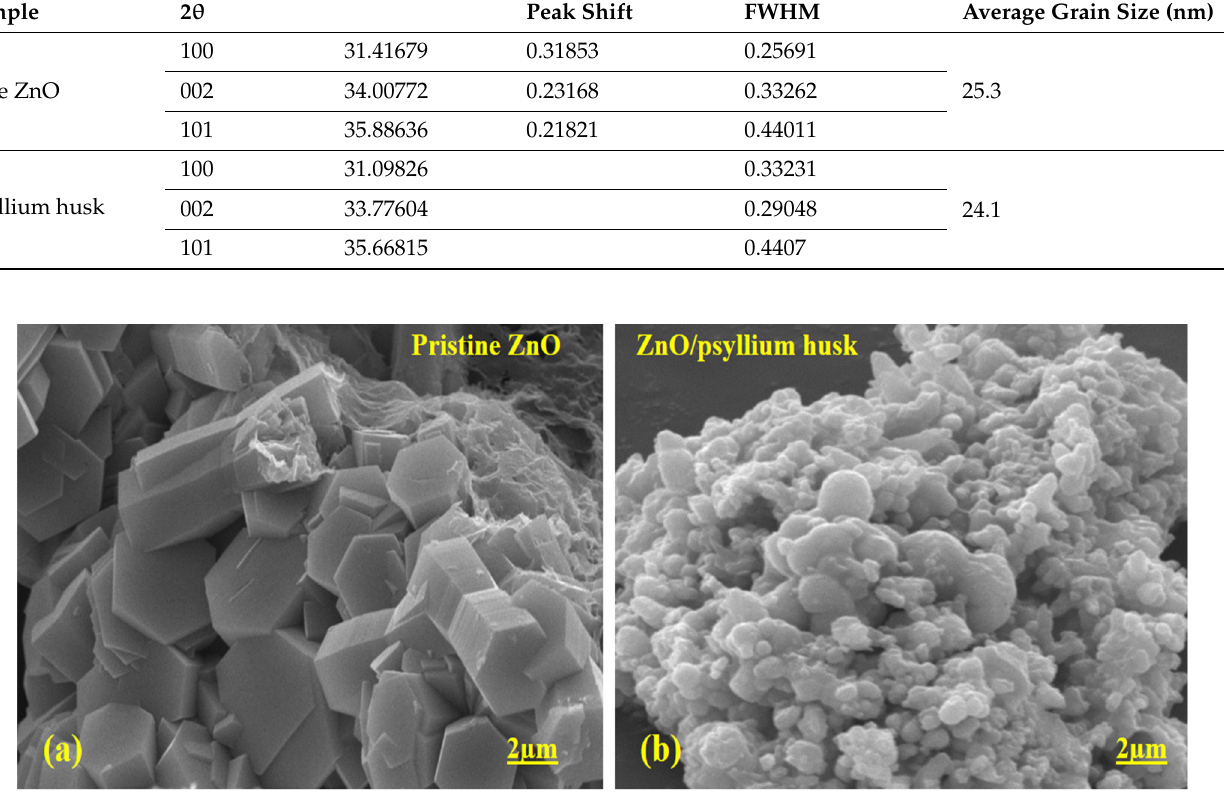
Figure 3. FTIR spectra showing curves for bare MB and ZnO–psyllium husk before and after color